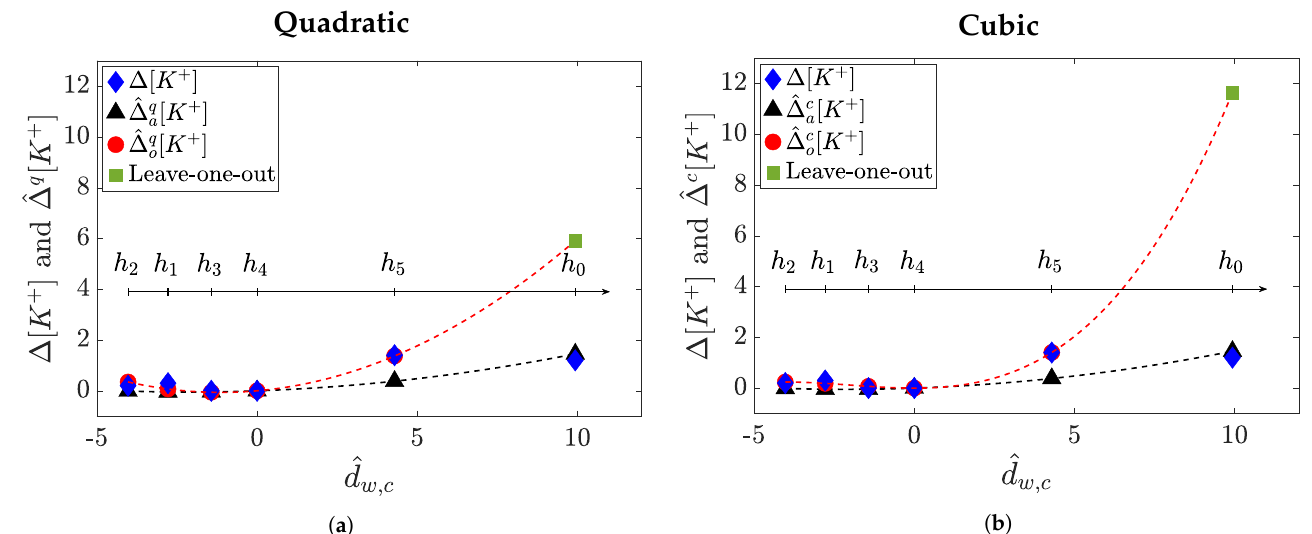
Figure 6. Example of leave-one-out model prediction ( m = o ) at h 0 compared to a m = a approach for a given patient. The quadratic models ( f = q ) are depicted in panel ( a ) while the cubic ones ( f = c ) are in panel ( b ). In each panel: The blue diamonds represent measured ∆ [ K + ] values at each hour { h 0 , h 1 , h 2 , h 3 , h 4 , h 5 } ; the black triangles are the estimated ˆ ∆ f [ K + ] while the red dots are ˆ ∆ f [ K + ] corresponding to the ˆ d w , c used in the training set { h } , and the 1 , h 2 , h 3 , h 4 , h 5 ˆ d ˆ d w , c , a w , c , o [ K + ] corresponding to the ˆ d w , c at h green square is the predicted ˆ ∆ f 0 , the hour excluded from the training set. The black- ˆ d w , c , o dashed line is the model in m = a while the red-dashed line accounts for the model in m = o